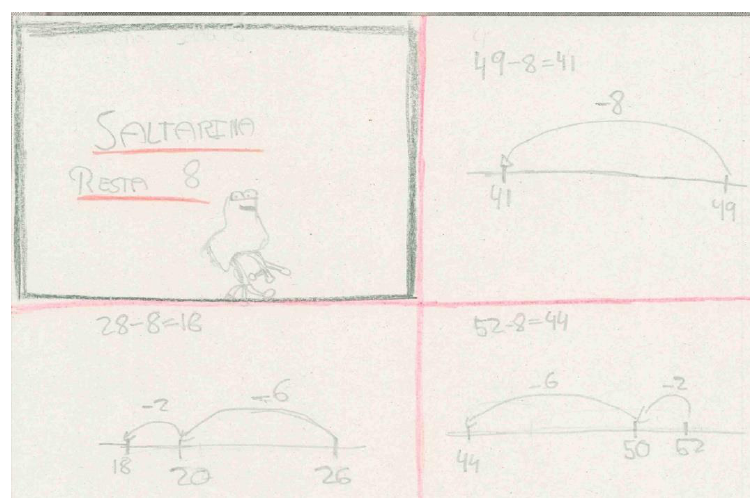
Figure 32. Saltarina’s worksheet: it subtracts eight.